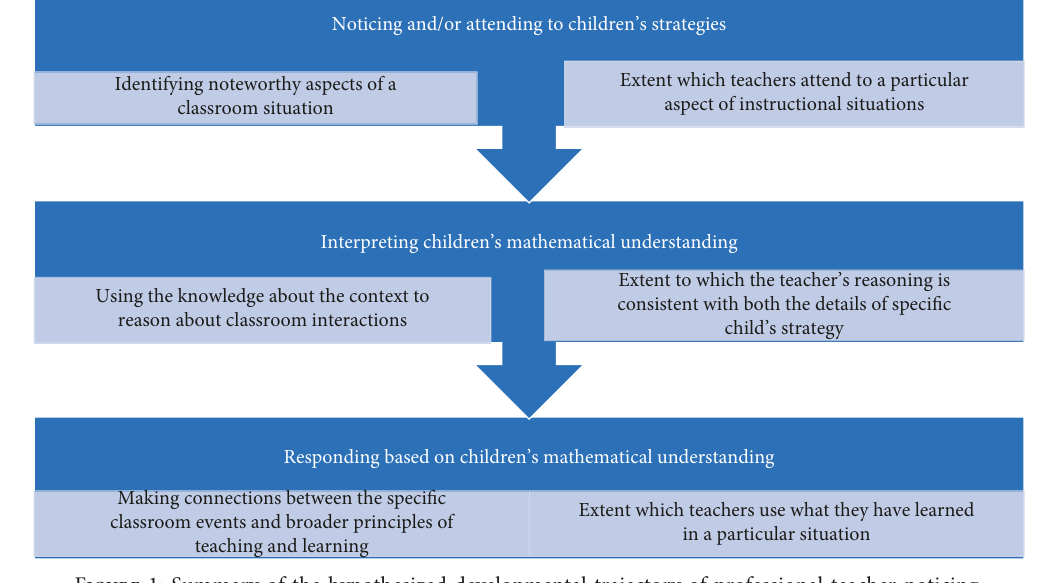
Figure 1: Summary of the hypothesized developmental trajectory of professional teacher